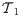
The transformation T1 in Case 1 of Theorem 18.